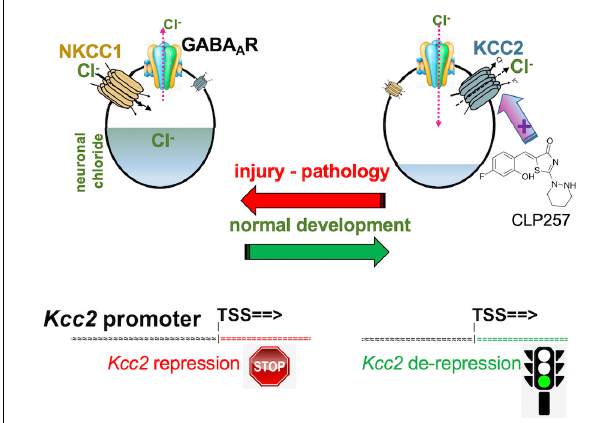
FIGURE 1 | Developmental CNS chloride shift reversed in neural injury. Note the central role of the KCC2 chloride-extruding neuronal transporter and regulation of the Kcc2 gene by de-repression. Compound CLP257 can enhance KCC2 chloride